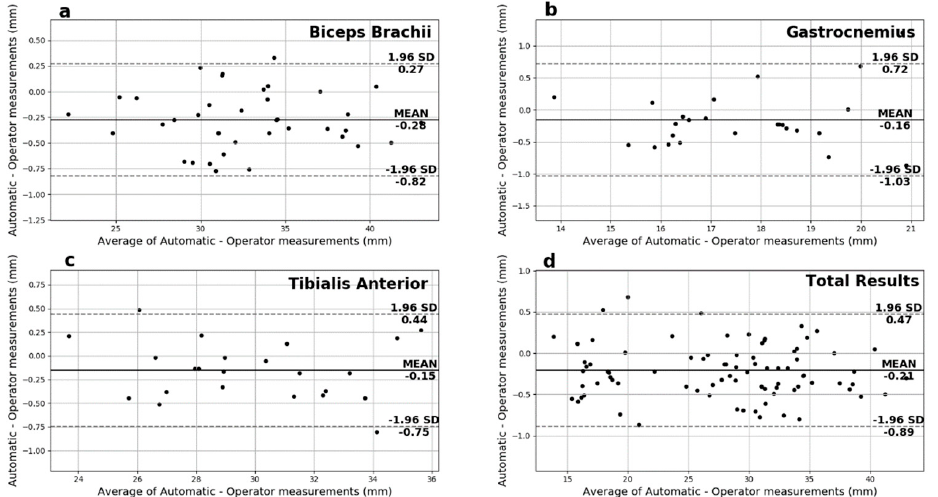
Figure 7. The Bland − Altman plots for the muscle thickness measurements for ( a ) biceps brachii, ( b ) gastrocnemius medialis, ( c ) tibialis anterior and ( d ) overall.